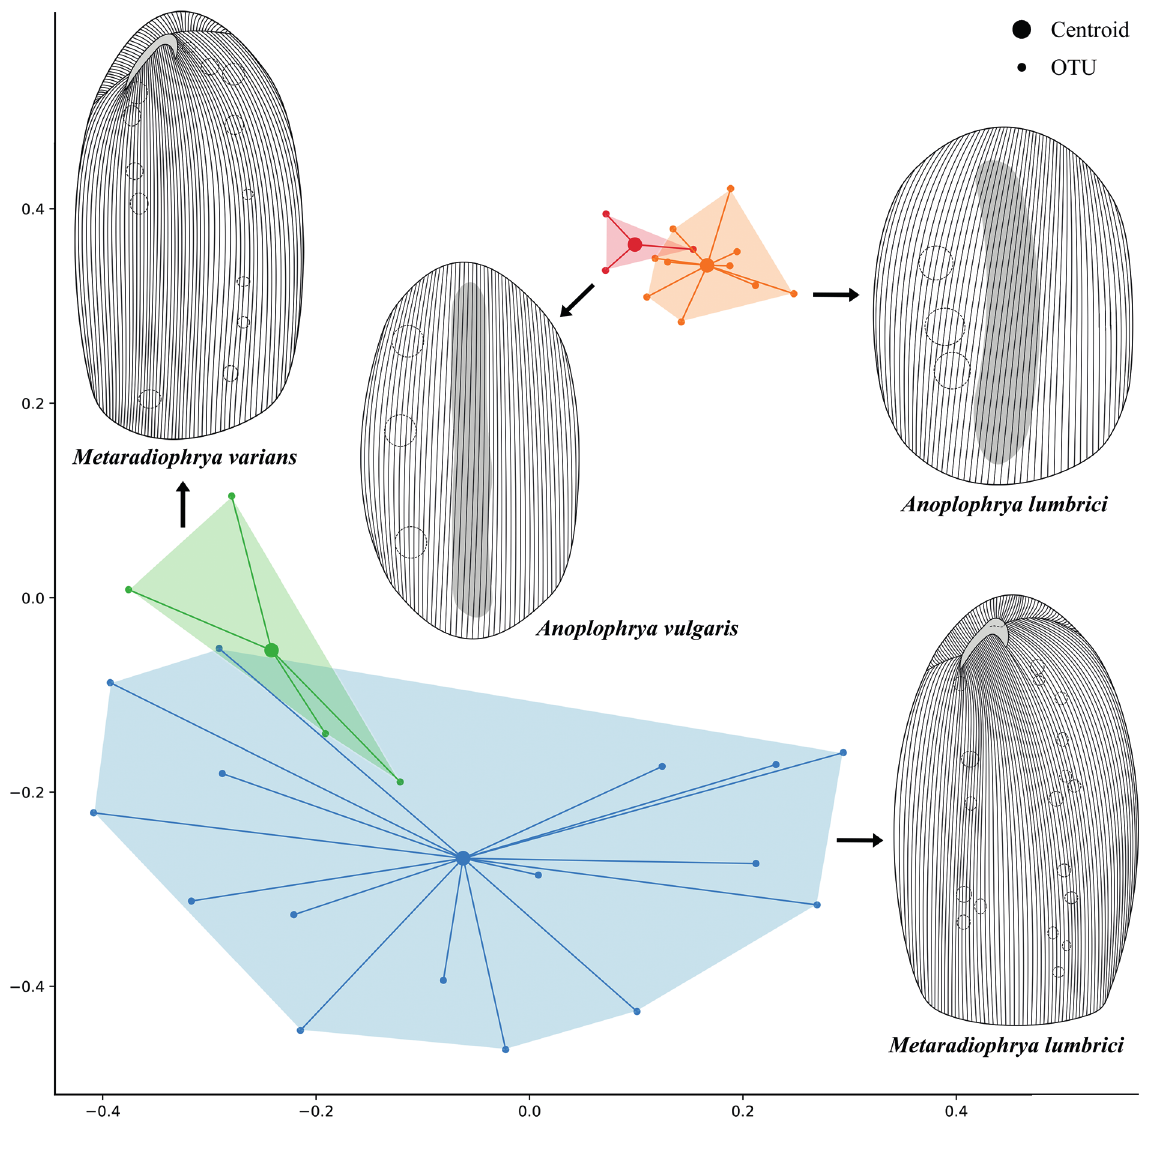
Fig. 13. Multidimensional scaling of 33 individuals based on pairwise Gower’s similarities calculated from 16 quantitative features, a single qualitative character and two derived